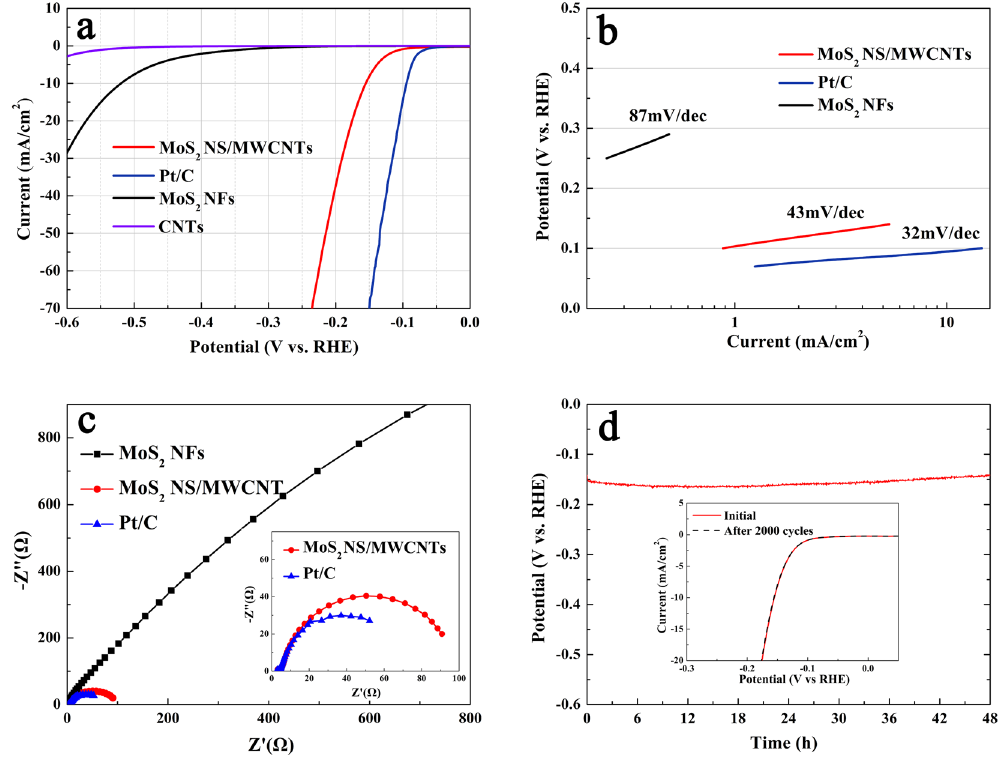
Figure 4. Polarization curves for catalysts ( a ) and the corresponding Tafel plots ( b ). ( c ) Impedance spectroscopy at an overpotential of 155 mV. ( d ) Durability test for the MoS 2 NS/MWCNT hybrid